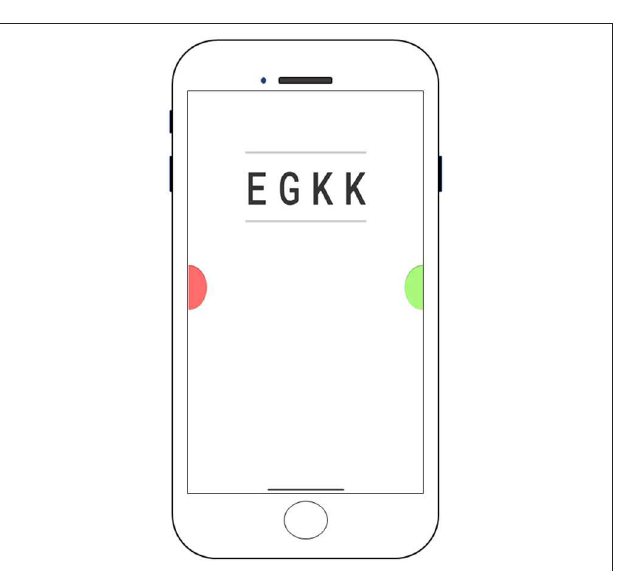
FIGURE 2 | “ICAO Code” screen of Location